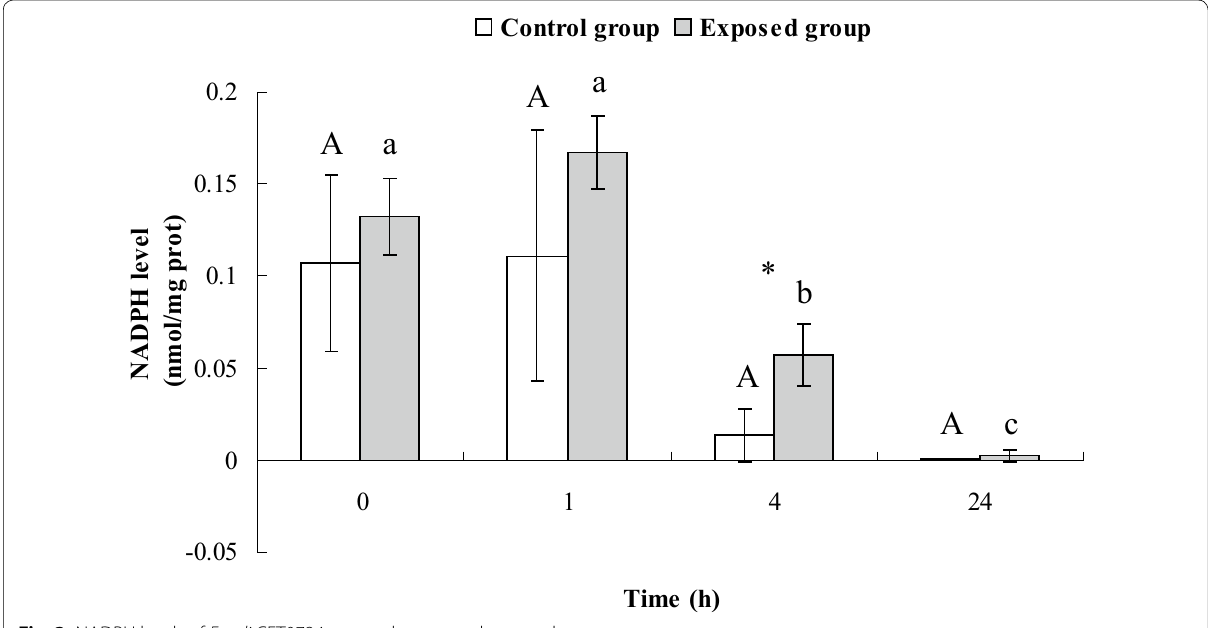
Fig. 3 NADPH levels of E. coli CFT073 in control group and exposed